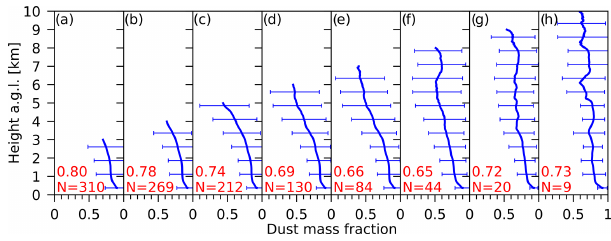
Figure 13. Mean dust mass fraction as a function of height up to (a) 3km, (b) 4km, (c) 5km, (d) 6km, (e) 7km, (f) 8km, (g) 9km, and (h) 10km. Each profile considers a different (decreasing) num- ber N of observations (given in each of the eight panels, total num- ber of observations is 328). Only observations with a backscatter coefficient clearly above zero up to the top height of the profile, so that a dust mass fraction could be calculated, are considered. Profiles showing pure Rayleigh scattering in the upper part of the height profiles (below the defined (a) – (h) top height) are excluded from the averaging. The bars indicate the atmospheric variability (1 SD). The profile mean dust mass fraction obtained from the shown 8 mean dust profiles are given as numbers together with the available number, N , of profiles in each of the eight averaging processes (see text for more details).